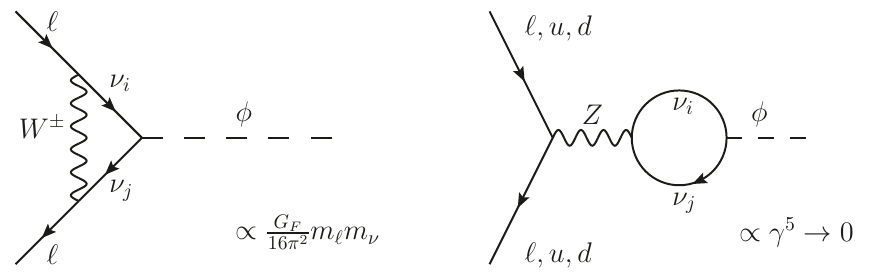
Figure 1 . One-loop diagrams that give rise to e(cid:11)ective couplings of (cid:30) with charged leptons ( ‘ ) or quarks ( u , d ). The left diagram is computed in eqs. (3.10){(A.2), and the right diagram leads to a pseudo-scalar coupling (with (cid:13) 5 ), the e(cid:11)ect of which however is suppressed in unpolarized matter. The diagrams are presented in the mass basis ( (cid:23) i and (cid:23) j are mass eigenstates). For an equivalent description in the chiral basis, see (cid:12)gure 2.